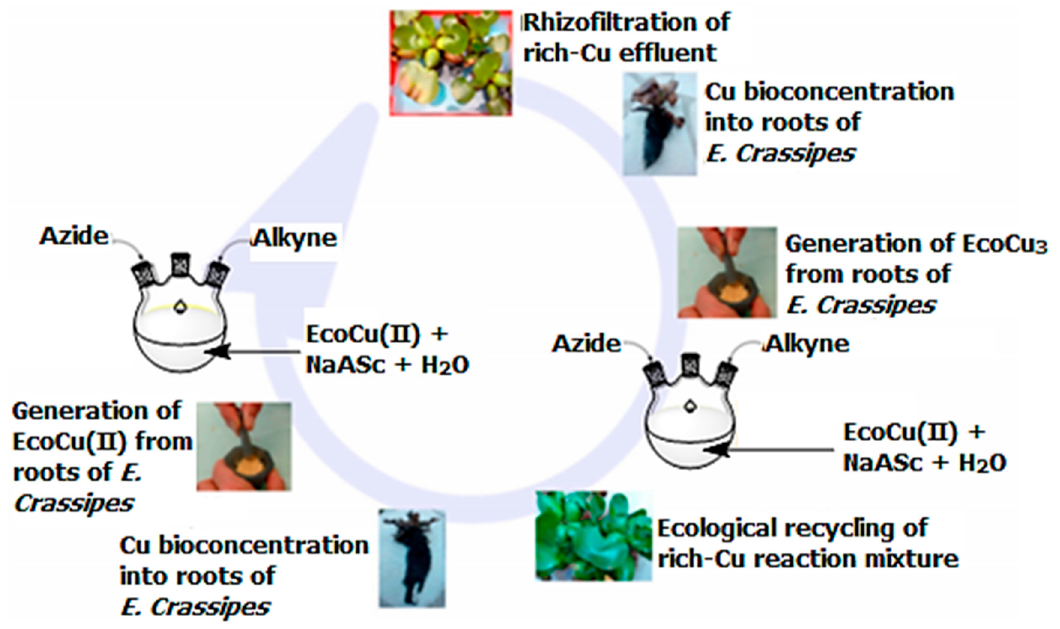
Figure 3. The eco-Cu-NPs was recycled based on the rhizofiltration.